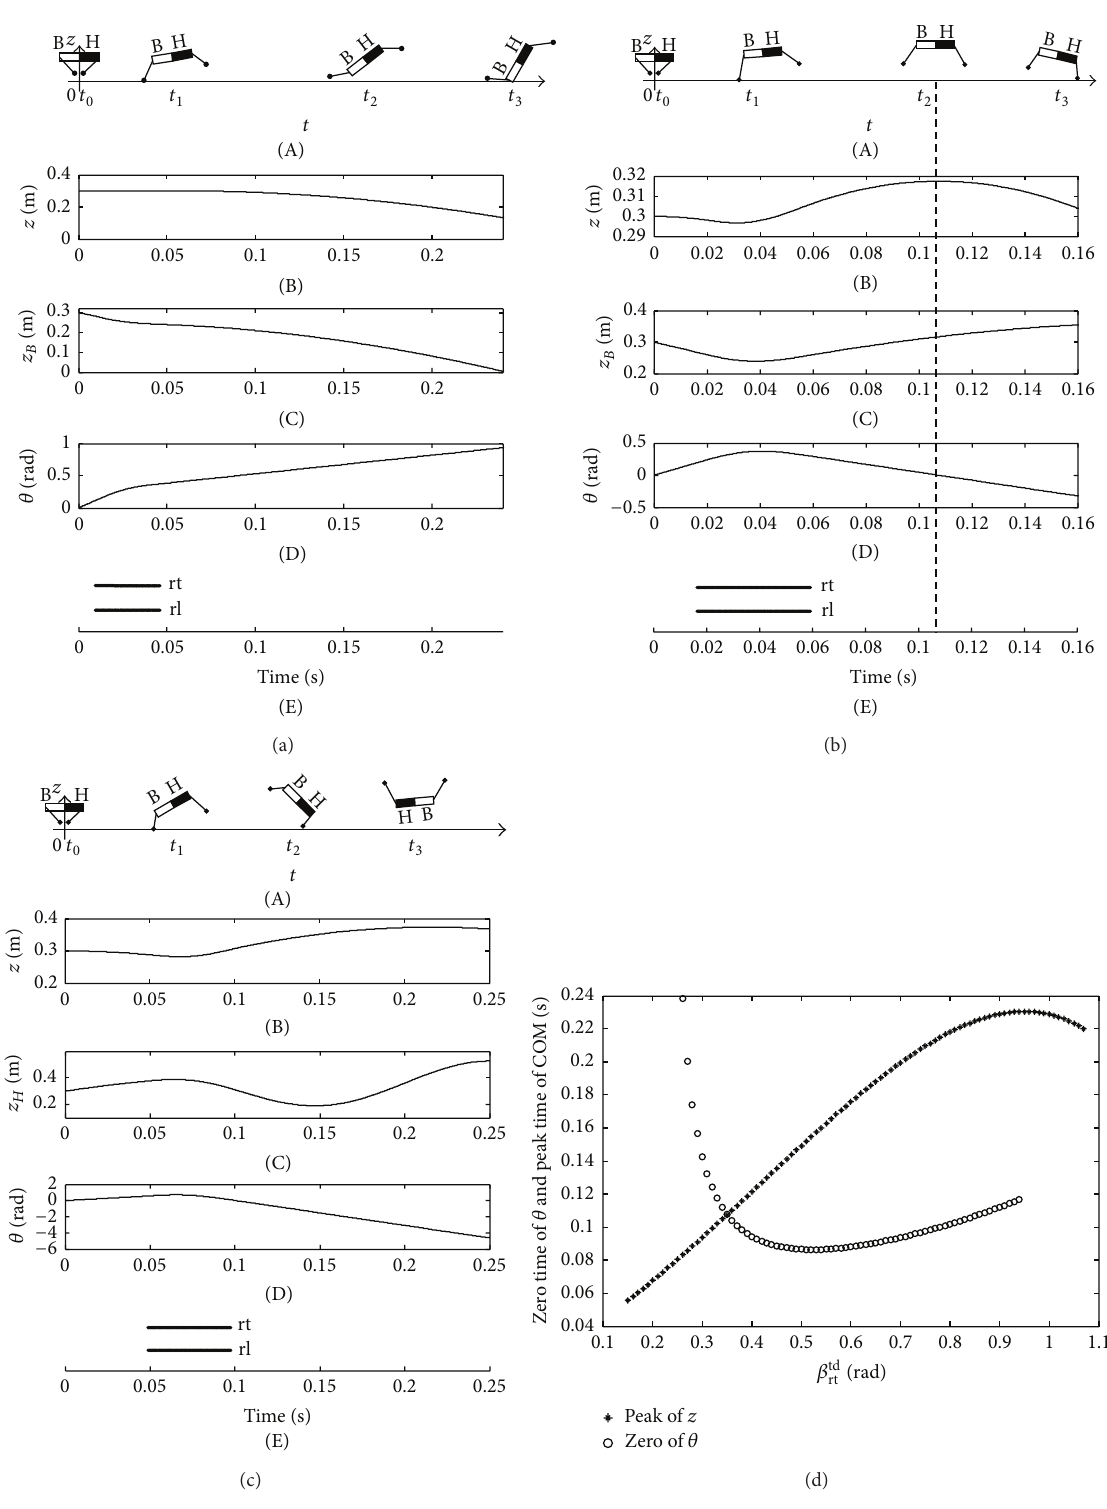
Figure14:Imbalanceandbalanceposturesofcat.(a)Theimbalanceposturewhen 𝛽 td rt = 0 . 15 rad;(b)thebalanceposturewhen 𝛽 td rt = 0 . 35 rad; (c) the imbalance posture when 𝛽 td rt = 0 . 80 rad; (d) the zero time of pitching angle and the peak time of